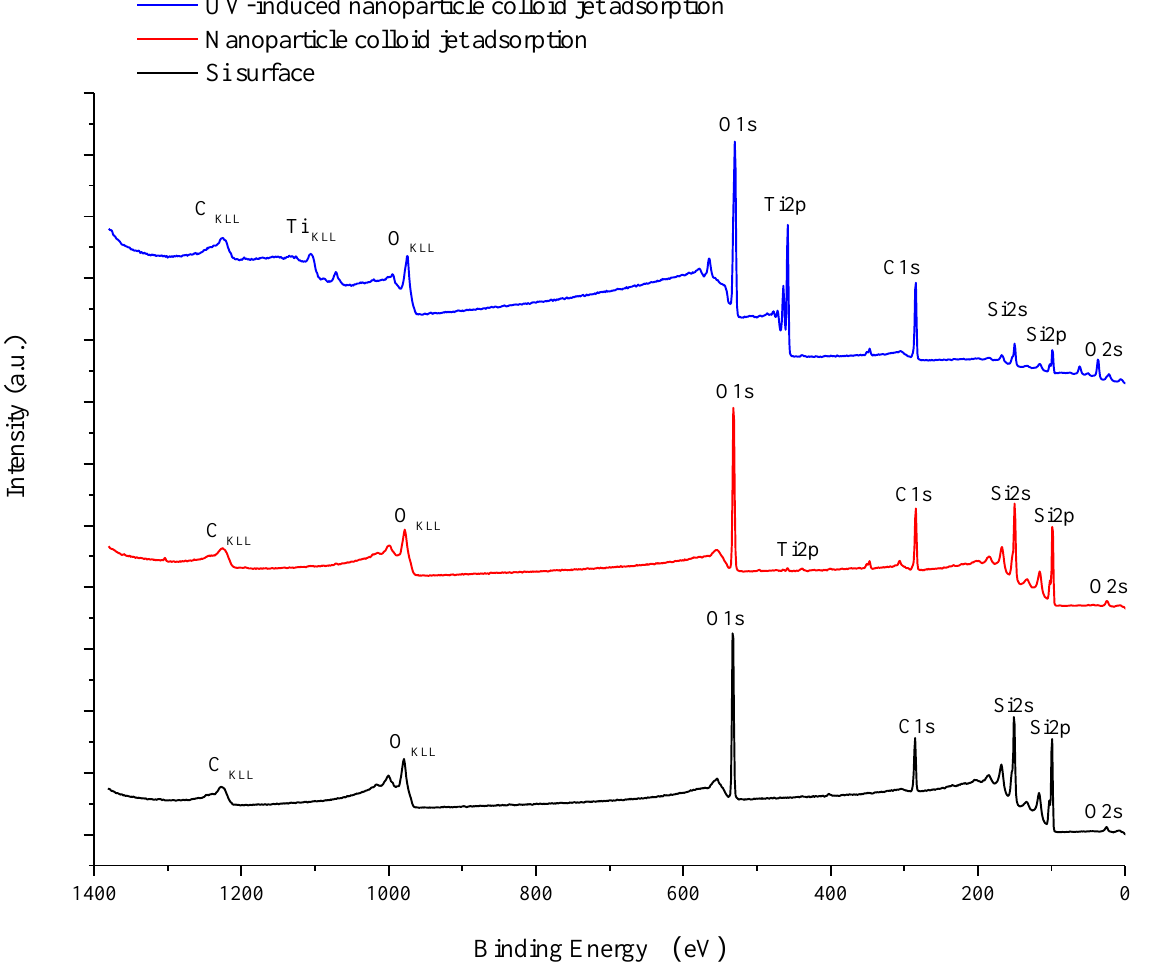
Figure 10. Full XPS spectrum of the three Si workpiece surface samples.